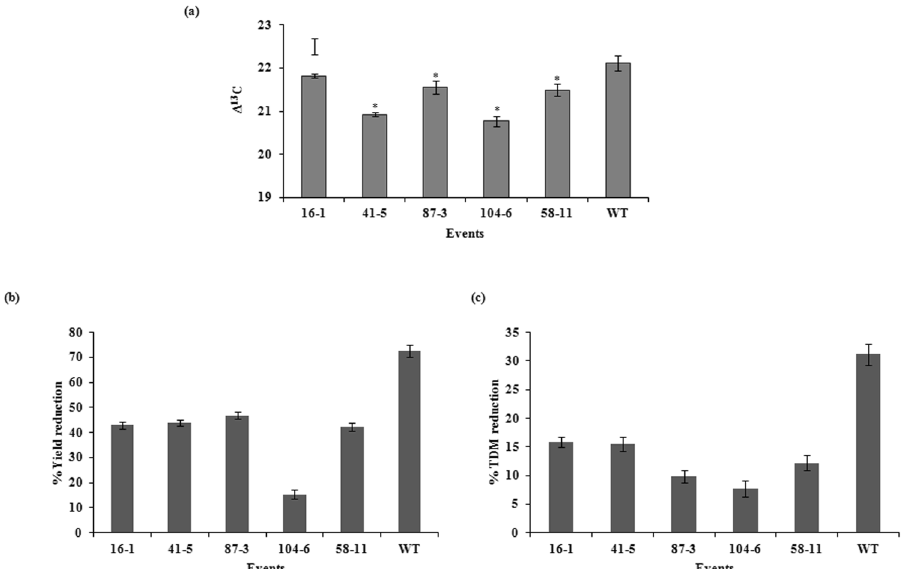
Figure 8. Water use efficiency and yield in the transgenic plants at moderate water stress of 70% FC. ( a ) Carbon isotope discrimination ( Δ 13 C) in the leaves of transgenic events and WT; percent reduction in yield ( b ) and TDM ( c ) in the transgenic events at maturity when compared to